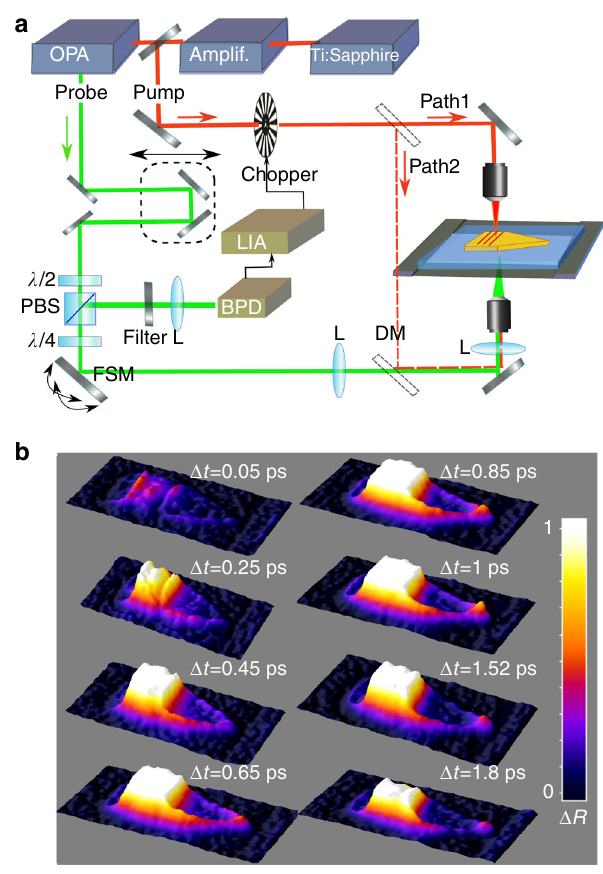
Fig. 2 Thermore fl ectance measurements. a Sketch of the time-domain thermore fl ectance setup: PBS polarizing beam splitter, λ /4 and λ /2 quarter- and half-waveplates, BPD balanced photodiode, DM dichroic mirror, FSM fast-steering mirror, L lens, LIA lock-in ampli fi er. b Re fl ectance- variation ( Δ R ) images recorded at different pump – probe delay times, Δ t = 0.05, 0.25 … and 1.8 ps. The image series shows the initial SPP launching followed by propagation along the taper, and eventually the formation and disappearance of a bright spot at the apex. The 16 × 6 μ m 2 saturated images are presented using the same color scale. A movie is available